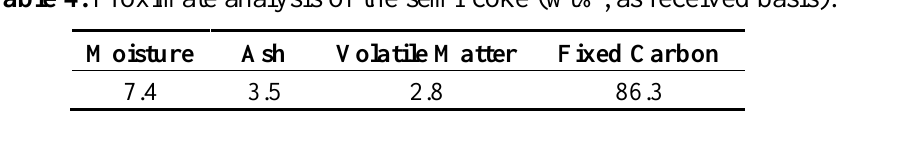
Table 5. Ash composition of the semi-coke (wt%).